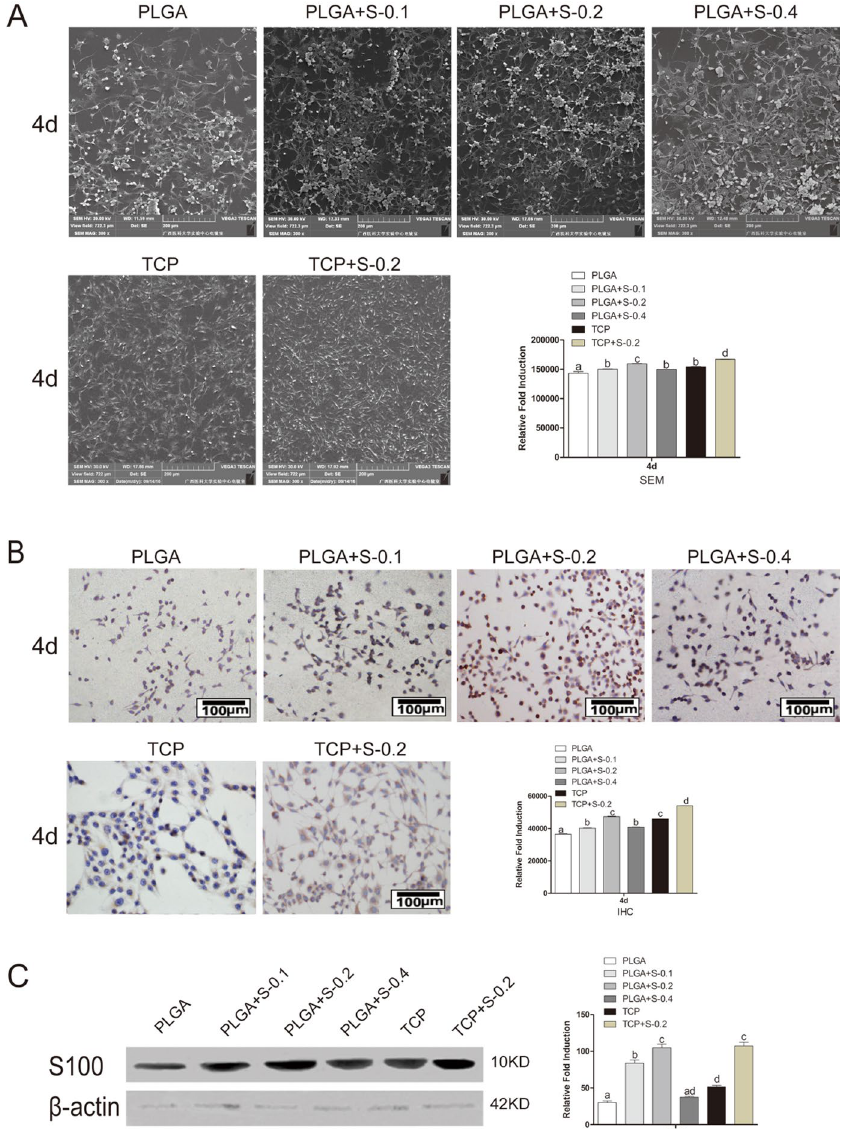
Figure 3. Effects of SDS on RSC 96 via SEM, immunohistochemical analysis, Western Blot assay and gene expression analysis in vitro. ( A ) Scanning electron microscopy (SEM) of the cells on scaffolds at 4 days. (PLGA means cultured with 0 mM SDS, PLGA+S-0.1 means cultured with 0.1 mM SDS, PLGA+S-0.2 means cultured with 0.2 mM SDS, PLGA+S-0.4 means cultured with 0.4 mM SDS, TCP means cultured on TCP alone, TCP + s-0.2 means cultured with 0.2 mM SDS on TCP). Statistic analysis of scanning electron microscopy (SEM). Different letters denote significances with P < 0.05 and the same letter shows no significant differences (P ≥ 0.05). ( B ) Immunohistochemical analysis for S-100 protein, RSC 96 showed positive cytoplasmic staining for S-100 at 4 days. (PLGA means cultured with 0 mM SDS, PLGA+S-0.1 means cultured with 0.1 mM SDS, PLGA+S-0.2 means cultured with 0.2 mM SDS, PLGA+S-0.4 means cultured with 0.4 mM SDS, TCP means cultured on TCP alone, TCP + s-0.2 means cultured with 0.2 mM SDS on TCP). Statistic analysis of immunohistochemical analysis. Different letters denote significances with P < 0.05 and the same letter shows no significant differences (P ≥ 0.05). ( C ) Western Blot assay of S-100 protein and quantification of the proteins expression. Full-length blots are presented in supplementary information. Different letters denote significances with P < 0.05 and the same letter shows no significant differences (P ≥ 0.05); ( D ) Gene expression analysis of important neurotrophic factors (GDNF, BDNF and CNTF) by qRT-PCR in six groups at 2, 4 and 6 days. The gene expression levels were analyzed by the 2 −ΔΔCT method using GAPDH as the internal control. The data represent the mean of three independent experiments (n = 3, mean ± SEM). Different letters denote significances with P < 0.05 and the same letter shows no significant differences (P ≥ 0.05). (PLGA means cultured with 0 mM SDS, PLGA+S-0.1 means cultured with 0.1 mM SDS, PLGA+S-0.2 means cultured with 0.2 mM SDS, PLGA+S-0.4 means cultured with 0.4 mM SDS, TCP means cultured on TCP alone, TCP + s-0.2 means cultured with 0.2 mM SDS on